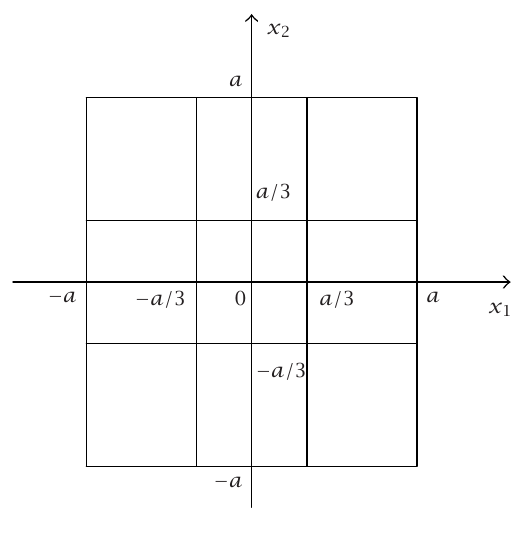
Figure 3.1. State